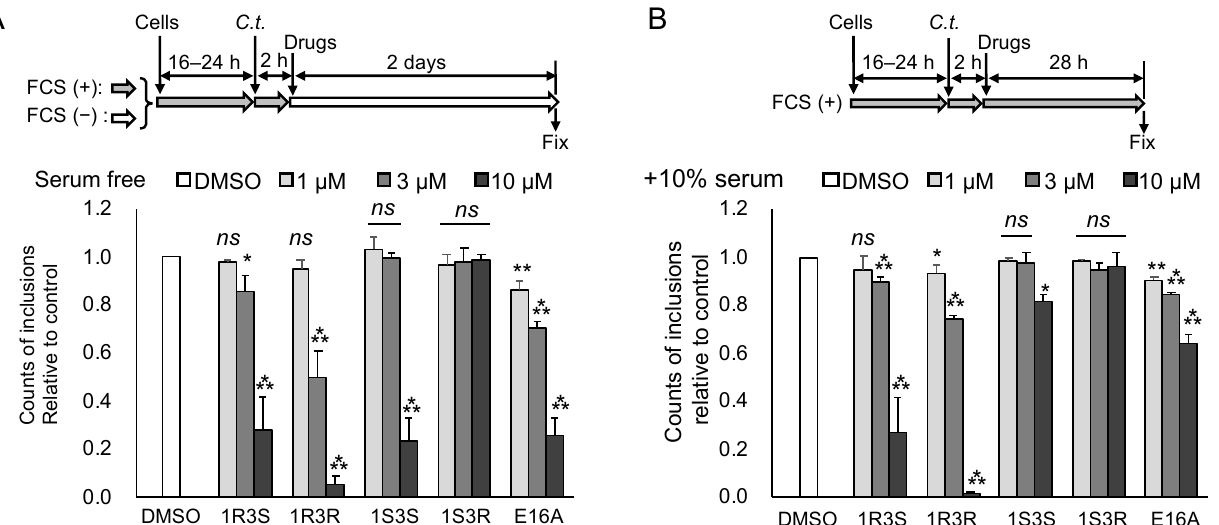
Figure 6. The anti-chlamydial activity of (1 R ,3 R )-HPA-12 is partially correlated with the inhibition of cidSM-synthesis. ( A ) The anti-chlamydial activity of HPA-12 stereoisomers and E16A under serum-free conditions. HeLa cells were infected with C. trachomatis in DMEM/10% FCS for 2 h at an MOI of 0.5 and were maintained in SF-DMEM containing various concentrations of each compound for 2 days, as summarized in the diagram ( upper panel). After fixing the cells, the inclusions were stained with FITC-conjugated anti-chlamydial LPS antibody, and FITC-positive spots with an area >50 µ m 2 were counted. The number of FITC-positive spots are presented relative to the values counted in the DMSO-treated control cells ( lower panel). Statistically significant values assessed by Dunnett’s test relative to the DMSO control are indicated (* p < 0.05; ** p < 0.01; *** p < 0.001; ns, not significant). The mean values ± SD from three experiments are shown. ( B ) The anti-chlamydial activity of the compounds under serum-containing conditions. The experimental setup was the same as that for the serum-free conditions, except that the cells were cultured with each compound in DMEM/10% FCS for 30 h post-infection ( upper panel). Statistically significant values assessed by Dunnett’s test are indicated (* p < 0.05; ** p < 0.01; *** p < 0.001; ns, not significant). The mean values ± SD from three experiments are shown ( lower